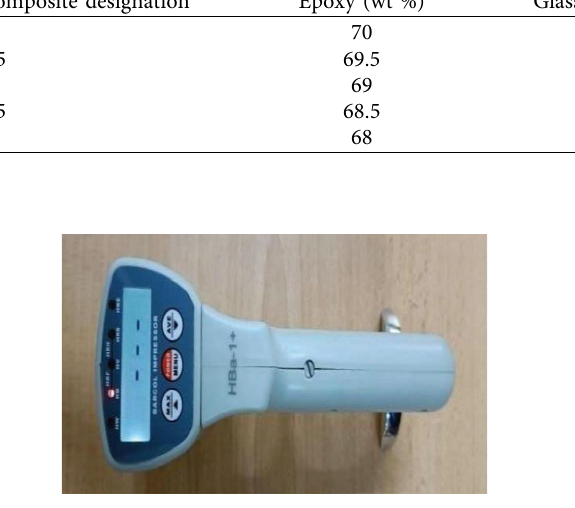
Figure 3: Barcol hardness